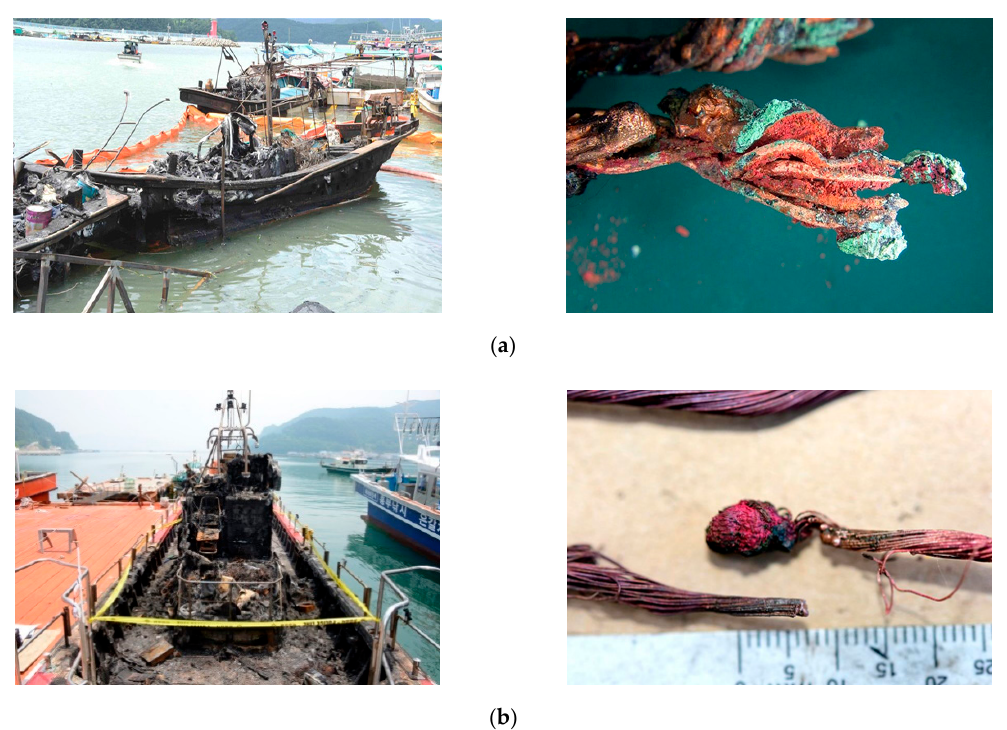
Figure 5. Fire accidents caused by DC series arcs on shipboards. ( a ) case 1; ( b ) case 2.